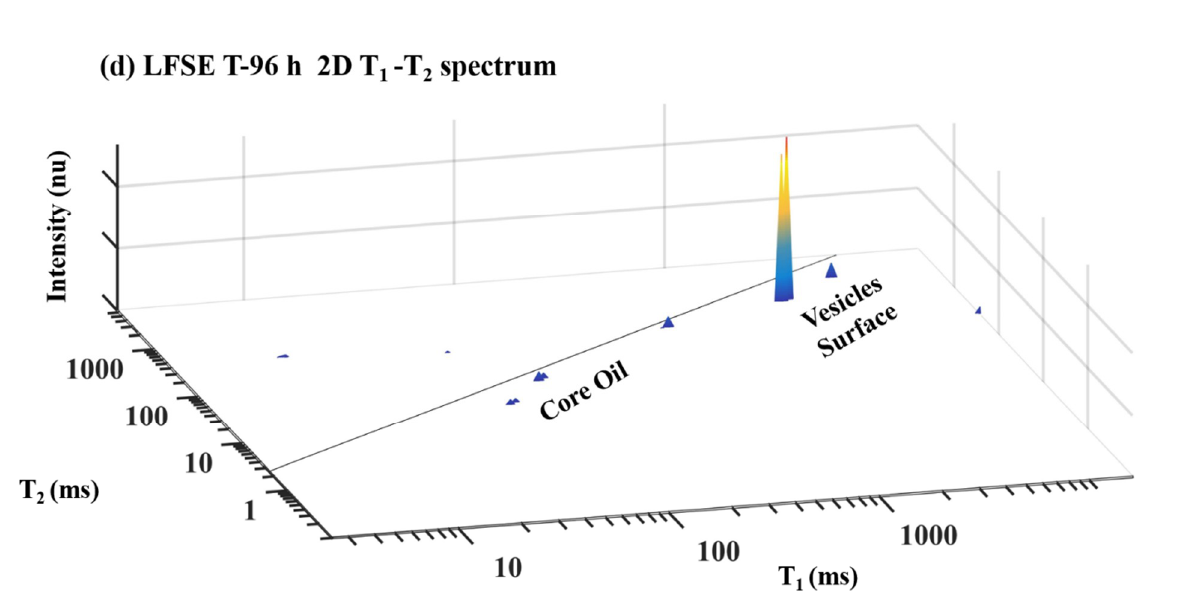
Figure 16. 1 H LF-NMR relaxation spectra of LSFE fresh produced (T-0 h, a , b ) and after 96 h of thermal oxidation at 55 ◦ C (T-96 h, c , d Figure 16. 1 H LF‐NMR relaxation spectra of LSFE fresh produced (T‐0 h, a , b ) and after 96 h of ther‐ mal oxidation at 55 °C (T‐96 h, c , d ).